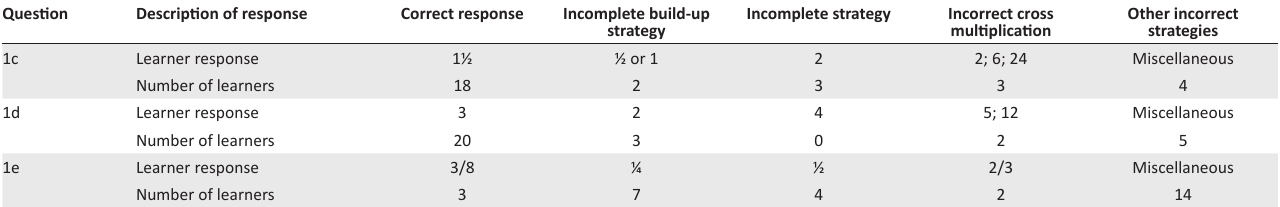
TABLE 2: Learner responses to Question 1c–e ( N = 30). Question